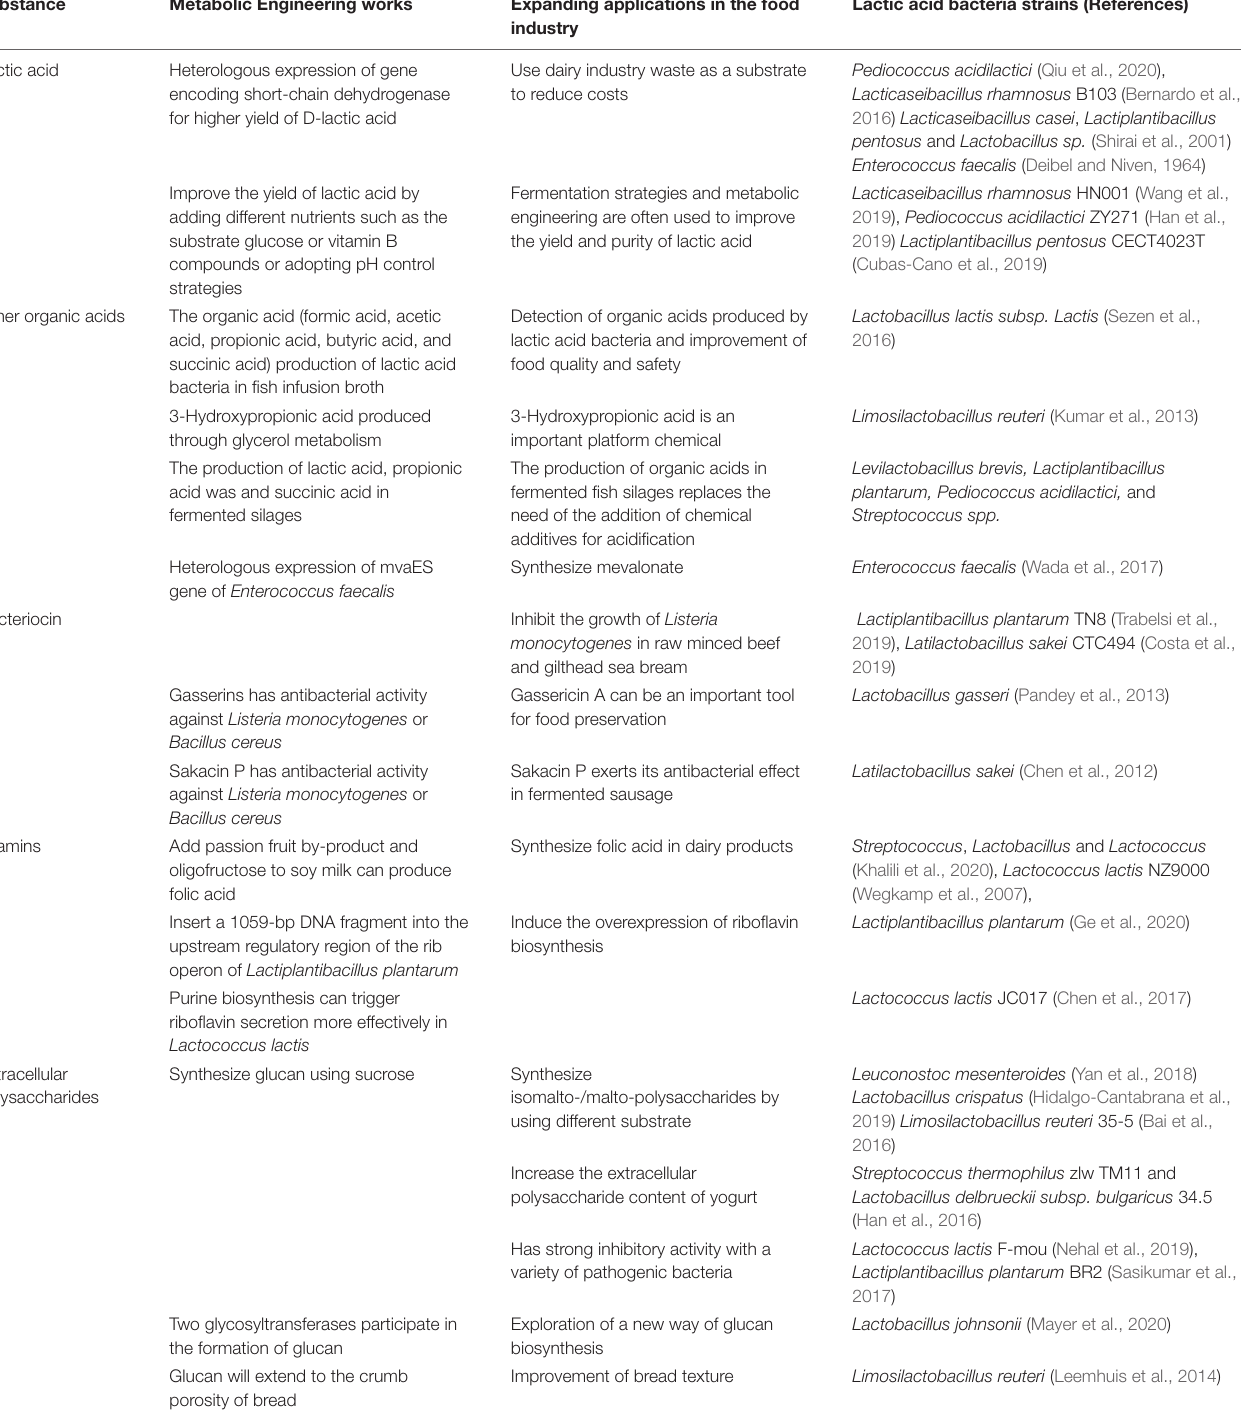
TABLE 2 | Substances synthesized in food by lactic acid